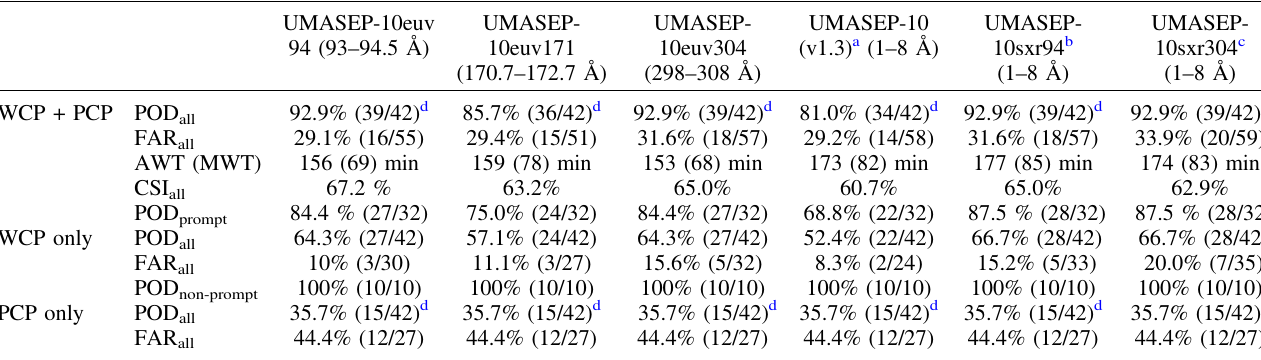
Table 10. Summary of forecasting performance of the current UMASEP-10 tool and other UMASEP-10-based tool which used the WCP-euv models for predicting all SWPC SEP events with energies >10 MeV that occurred from May 2010 to December 2017. The fi rst four rows present forecasting performance metrics using a speci fi c EUV-based or SXR-based WCP model jointly with the PCP model. From the fi fth row to the seventh row, the forecasting performance metrics using the WCP model alone are presented; and, the last three rows show the performance results of the PCP model which is used in all the presented UMASEP-10-based